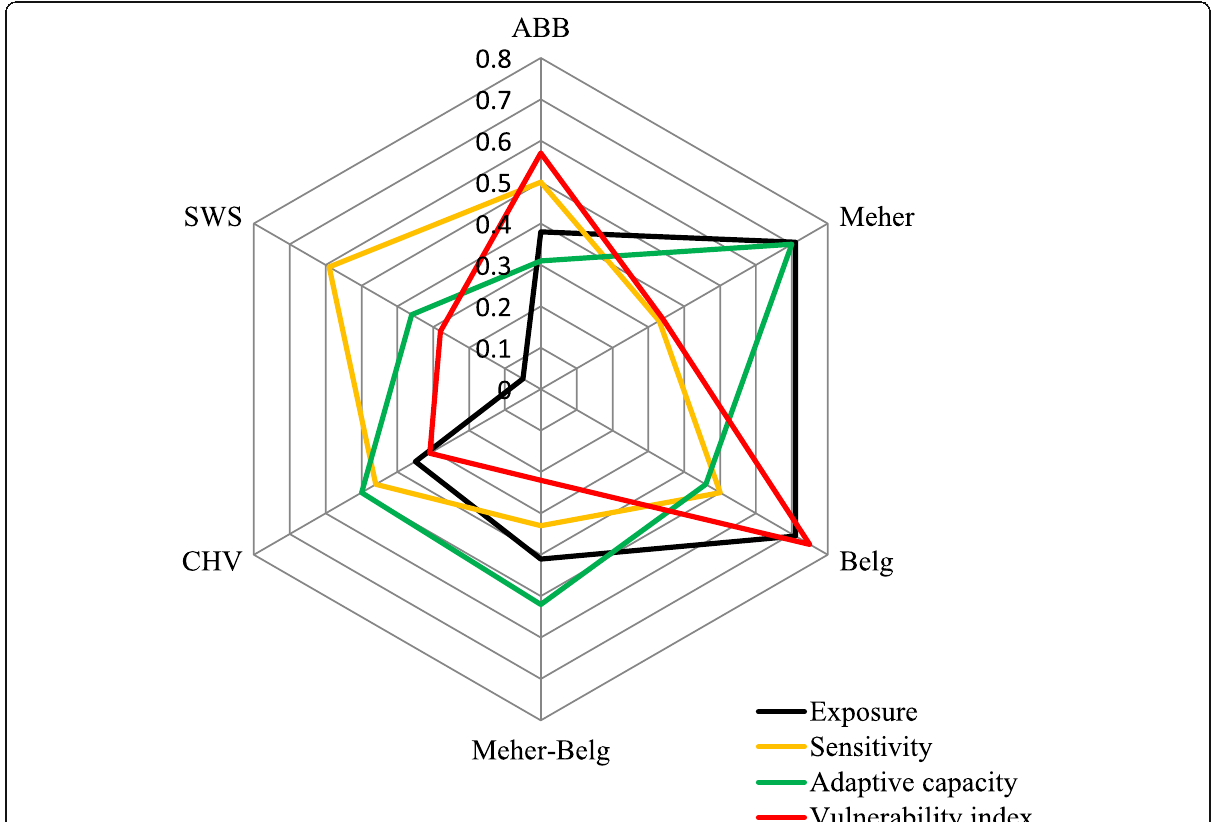
Fig. 11 Spider diagram showing livelihood zones ’ overall exposure, sensitivity, adaptive capacity, and vulnerability